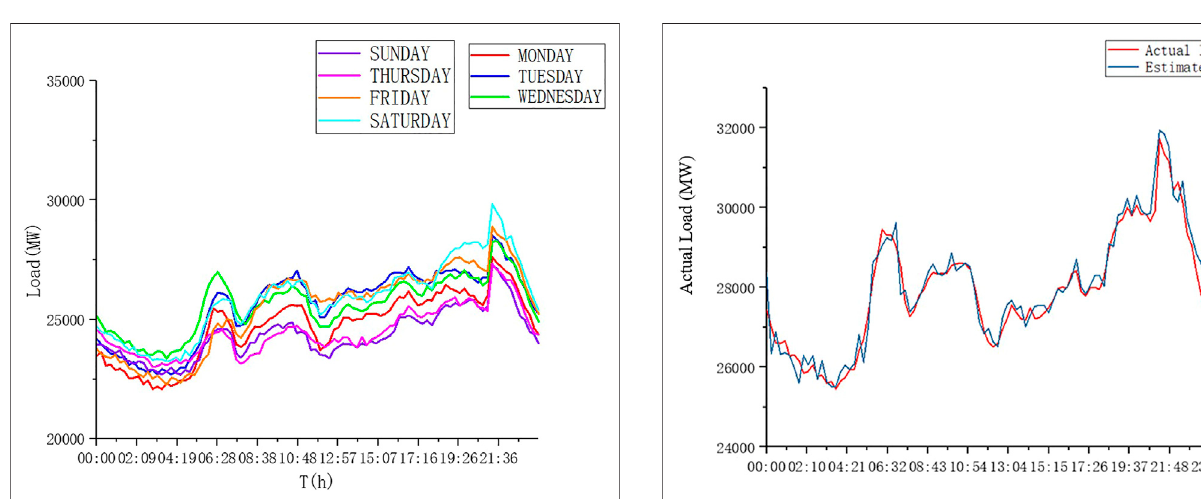
FIGURE 1 | Changes in electricity load data in a week.